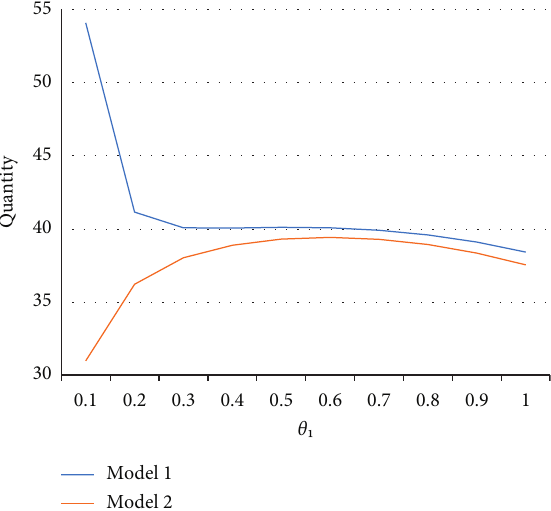
changes on total 1